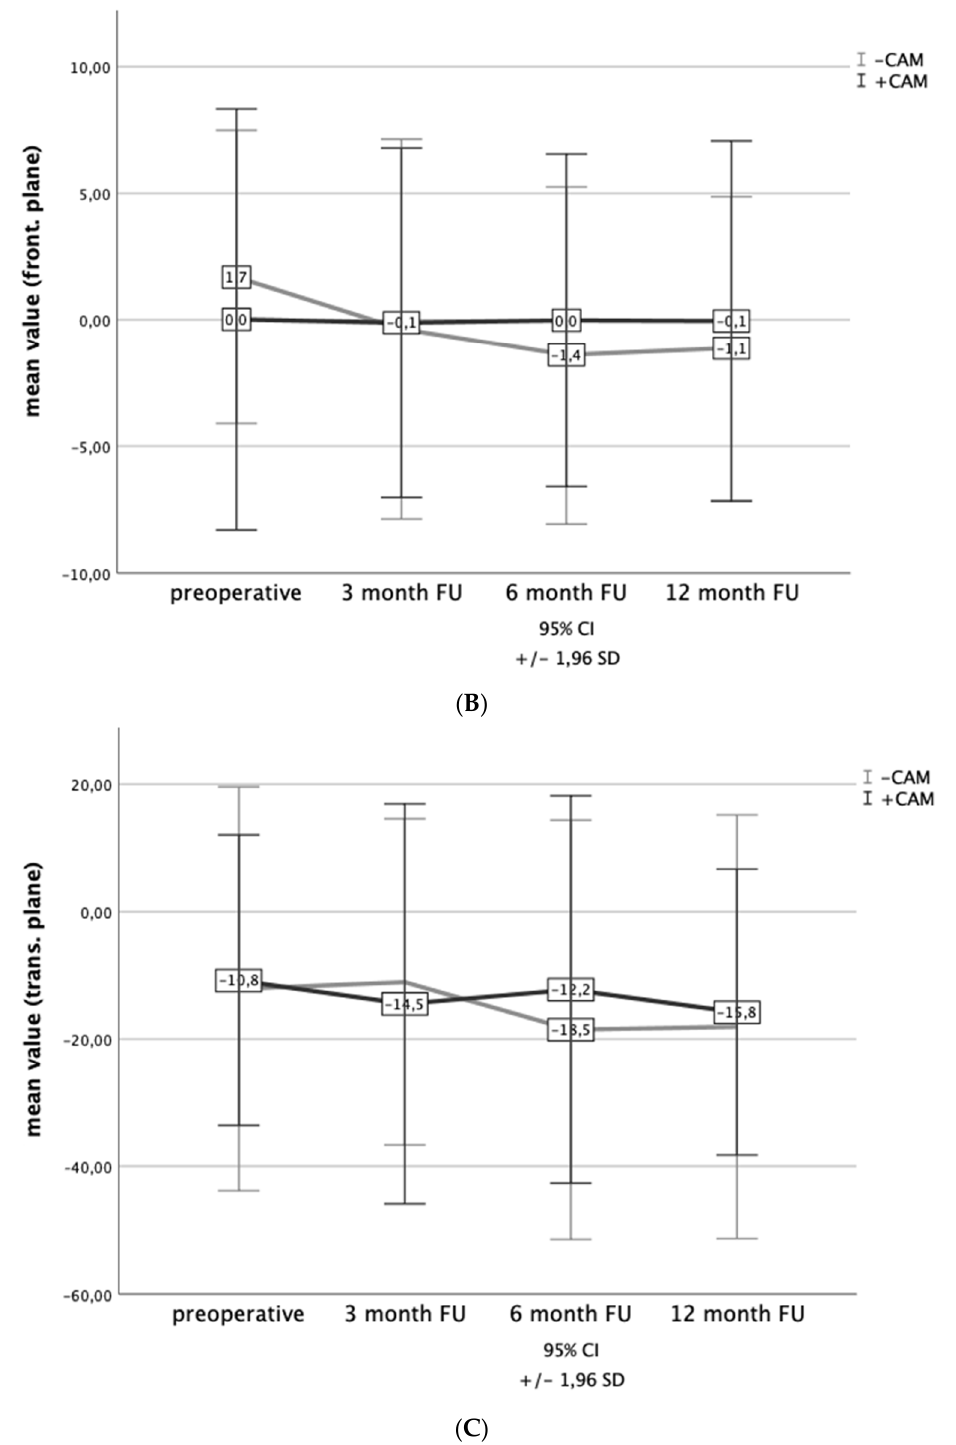
Figure 2. ( A – C ) The hip angles at the point of heel strike showed a constant course in the sagittal and frontal plane. Consistent with the results in Table 2, the transversal values decreased from the preoperative status to the last time of follow-up. Overall, no significant differences between patients with or without a cam morphology were observed.